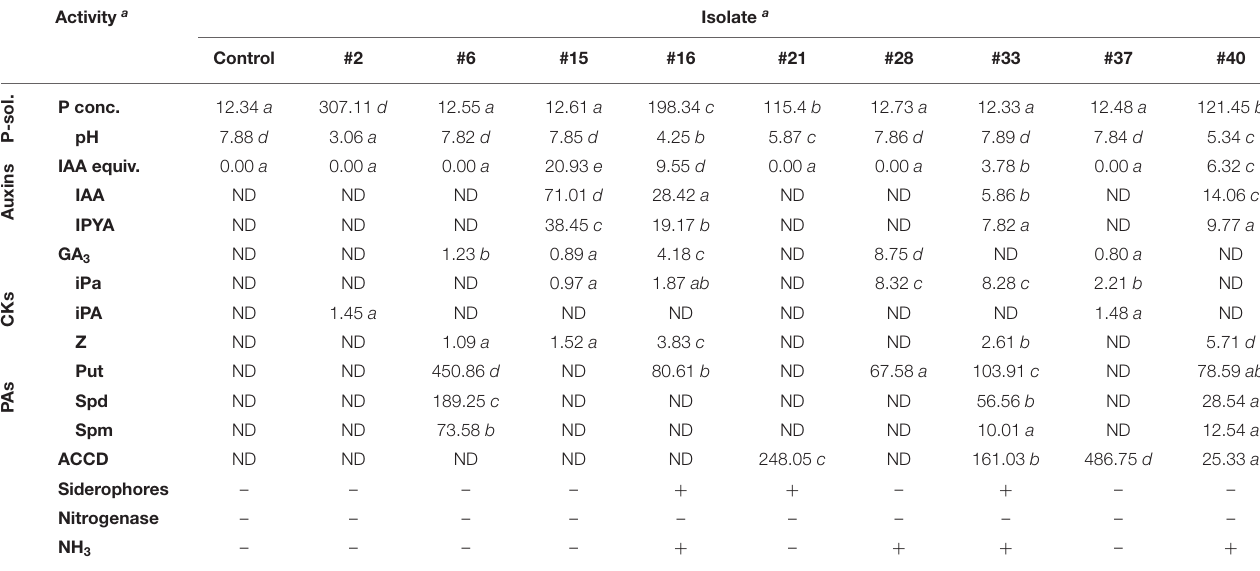
TABLE 2 | In vitro production of plant growth regulators (PGRs) ( µ g ml − 1 ), ACCD (nanomoles α -keto-butyrate mg − 1 protein h − 1 ), siderophores, nitrogenase enzyme, NH 3 ; and the effect of inoculation with rock phosphate (RP) amended Pikovskaya’s broth with the best performing rhizosphere-competent isolates obtained from the mangrove rhizosphere sediment on pH levels and concentrations of available P (mg L − 1